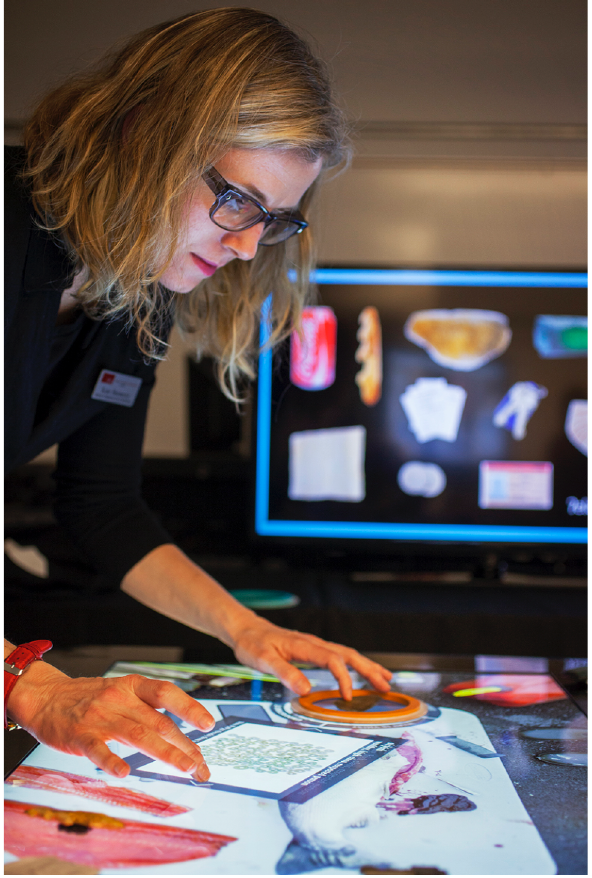
Figure 10 | Demonstrating ʔelə w̓k̓ ʷ – Belongings . Courtesy Reese